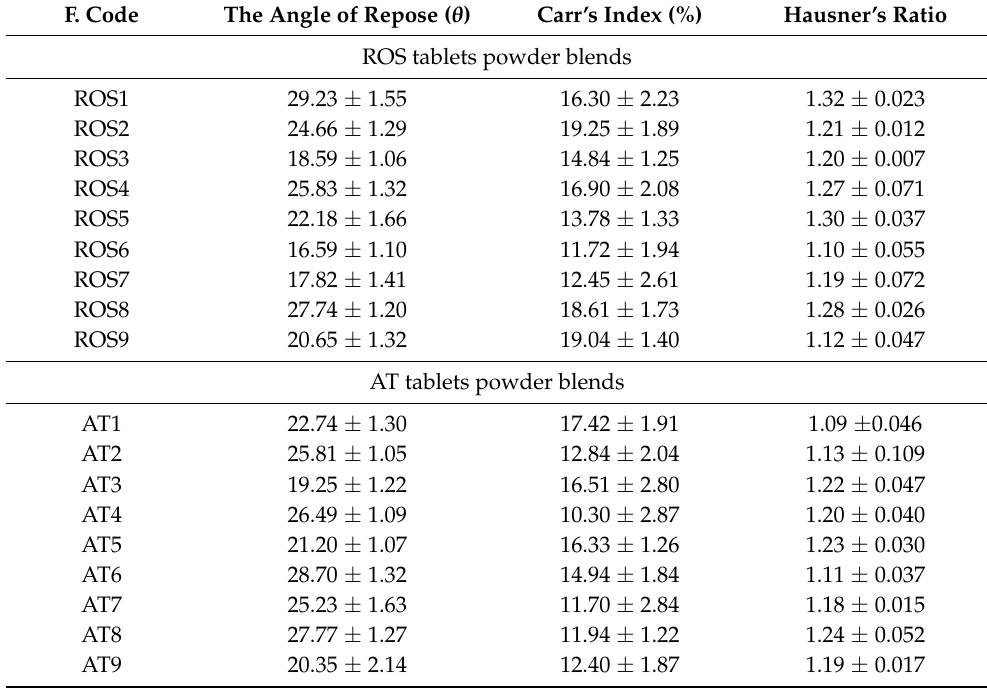
Table 5. Pre-compression characterization